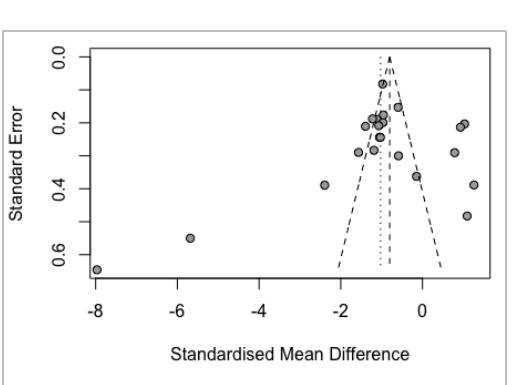
Figure A10. There are a few studies outside the confidence bounds for a fixed effect model, includ- ing outliers, but the studies are still somewhat balanced on either side of the effect estimates. So, the funnel plot does not reveal any clear presence of publication or other bias for stable MCI (MCI_St) versus MCI_AD.